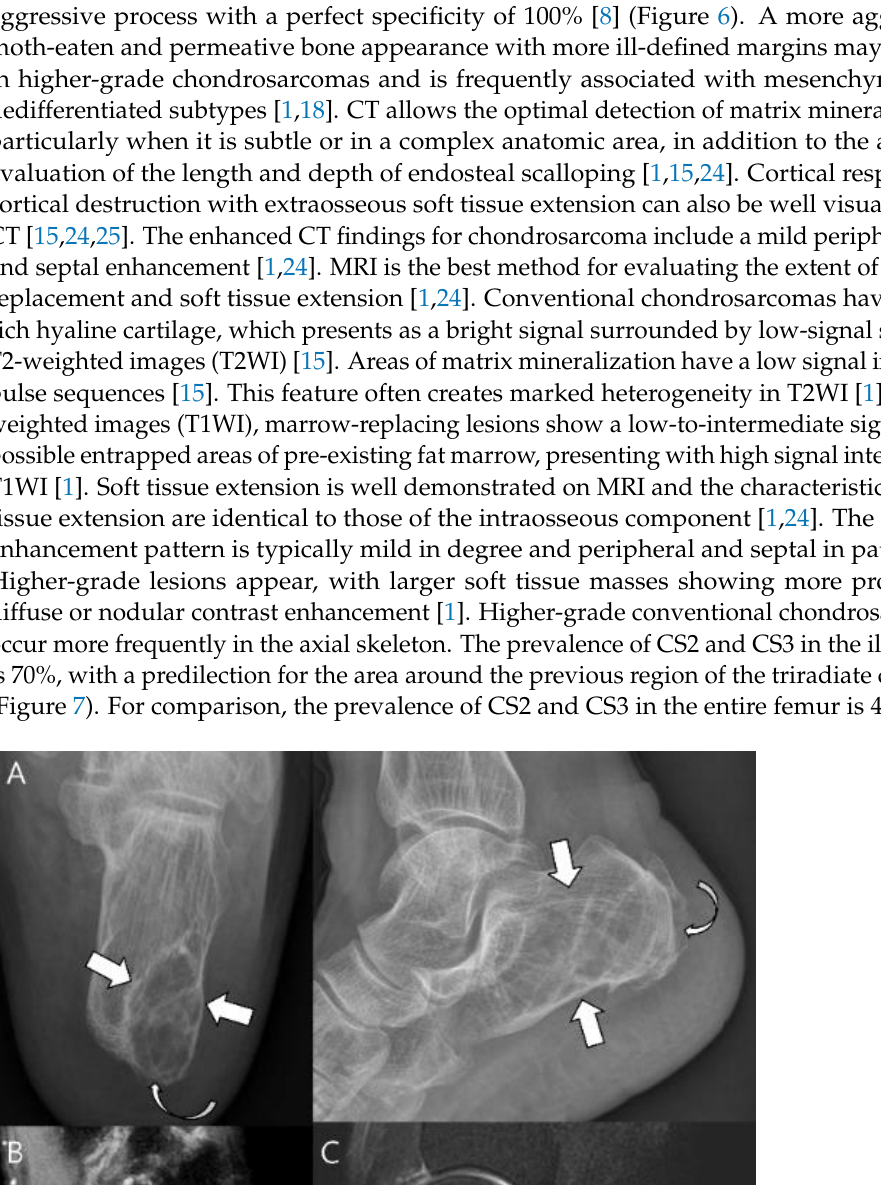
Figure 7. High-grade conventional chondrosarcoma of the acetabulum in a 49-year-old woman. ( A ) Axial CT scans reveal cortical breakage (thin arrow) with extraosseous extension containing matrix mineralization (curved arrow) in the left acetabulum. ( B ) Axial and ( C ) axial T1-weighted enhanced images with fat suppression show diffusely enhancing intraosseous (arrow) and ex- traosseous tumor components (curved arrow).